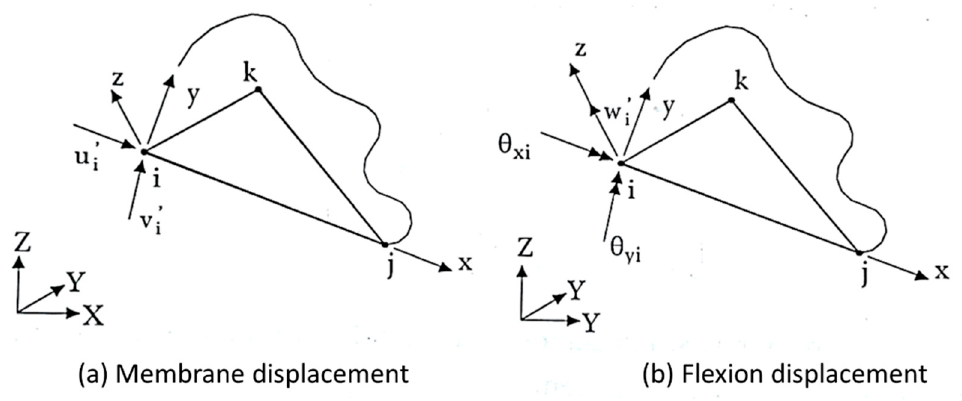
Figure 25. Triangle element in xy plane. Reproduced with permission [75] .